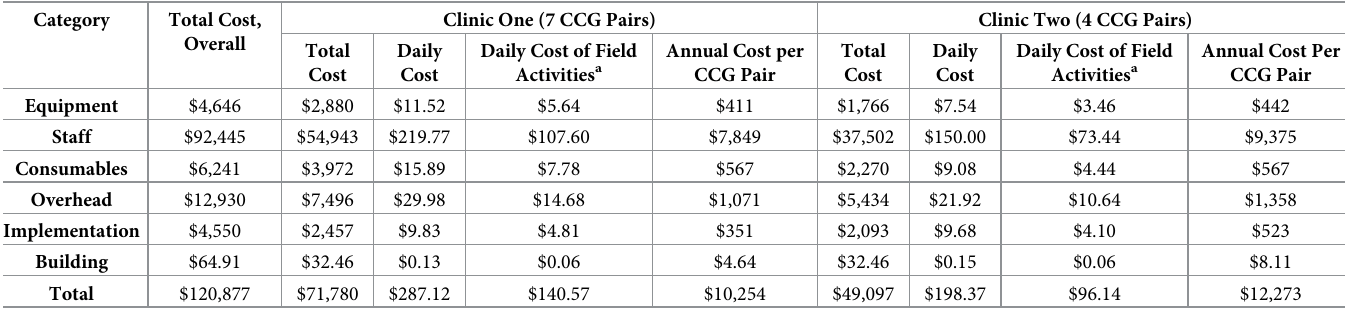
Table 3. Bottom-up cost estimates.